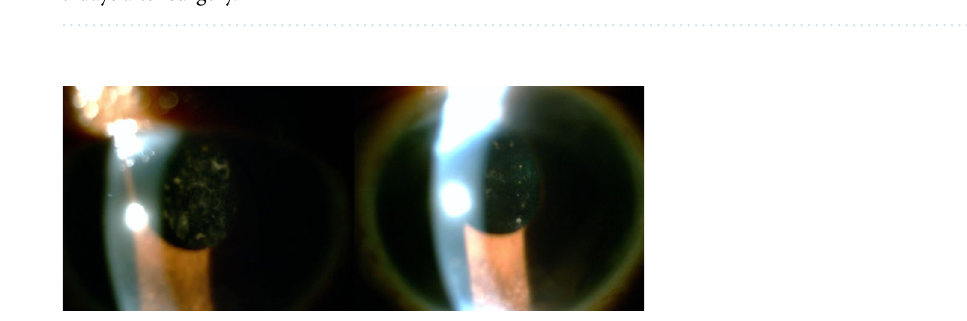
Figure 1. Gore-Tex suture exposure after surgery. In this case, the suture, not the knot, eroded the conjunctiva 7 days after surgery.